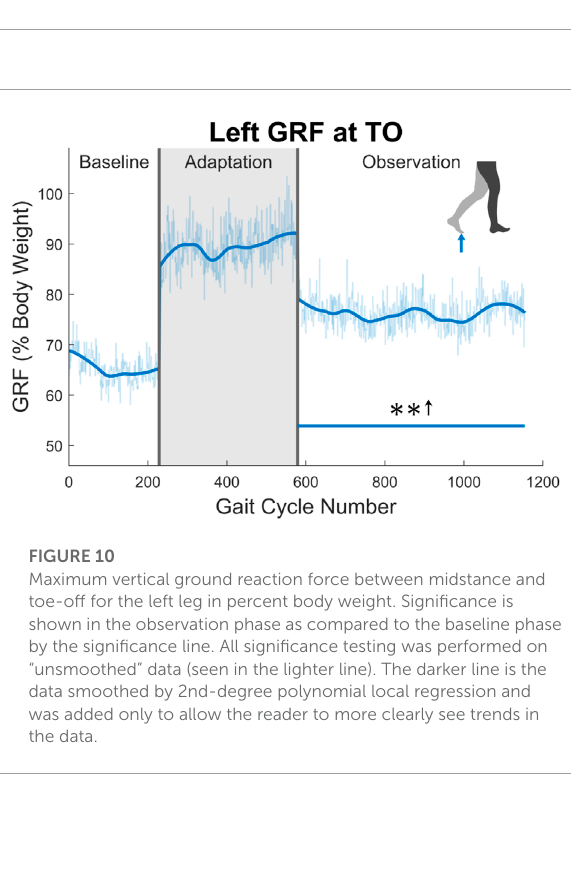
FIGURE 9 Maximum hip and knee angular velocities during the swing phase for both left and right legs. Significance is shown in the observation phase as compared to the baseline phase by the significance line. All significance testing was performed on “unsmoothed” data (seen in the lighter line). The darker line is the data smoothed by 2nd-degree polynomial local regression and was added only to allow the reader to more clearly see trends in the data.